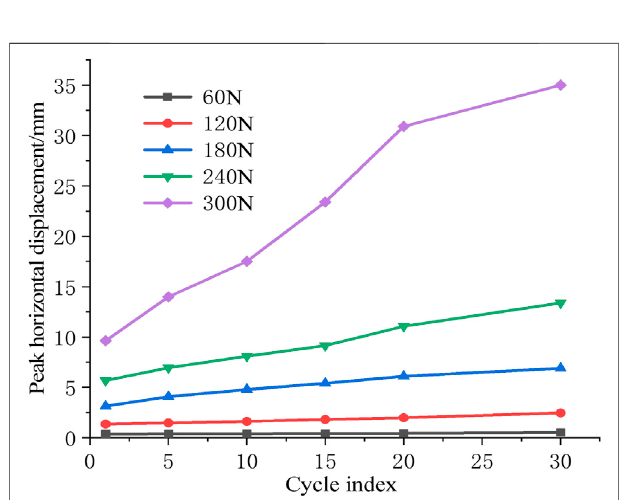
FIGURE 16 | Horizontal displacement peak curve of composite foundation under horizontal cyclic load.